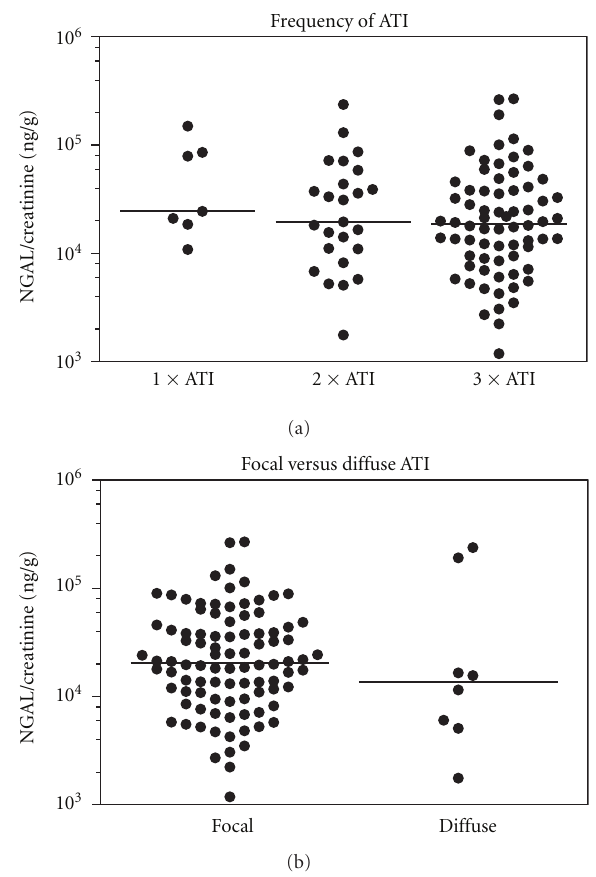
Figure 4: (a) Urinary NGAL/creatinine ratio depending on the frequency of ATI. Shown is the urinary NGAL/creatinine ratio depending on whether patients had 1 time ( n = 7), 2 times ( n = 25), or 3 times ( n = 70) findings of ATI in biopsies taken while being followed in the biopsy program. (b) Urinary NGAL/creatinine ratio in Tx patients with focal versus di ff use ATI. No significant di ff erences were found in the urinary NGAL excretion of patients with focal ( n = 94) versus di ff use ( n = 8) ATI findings after Tx.